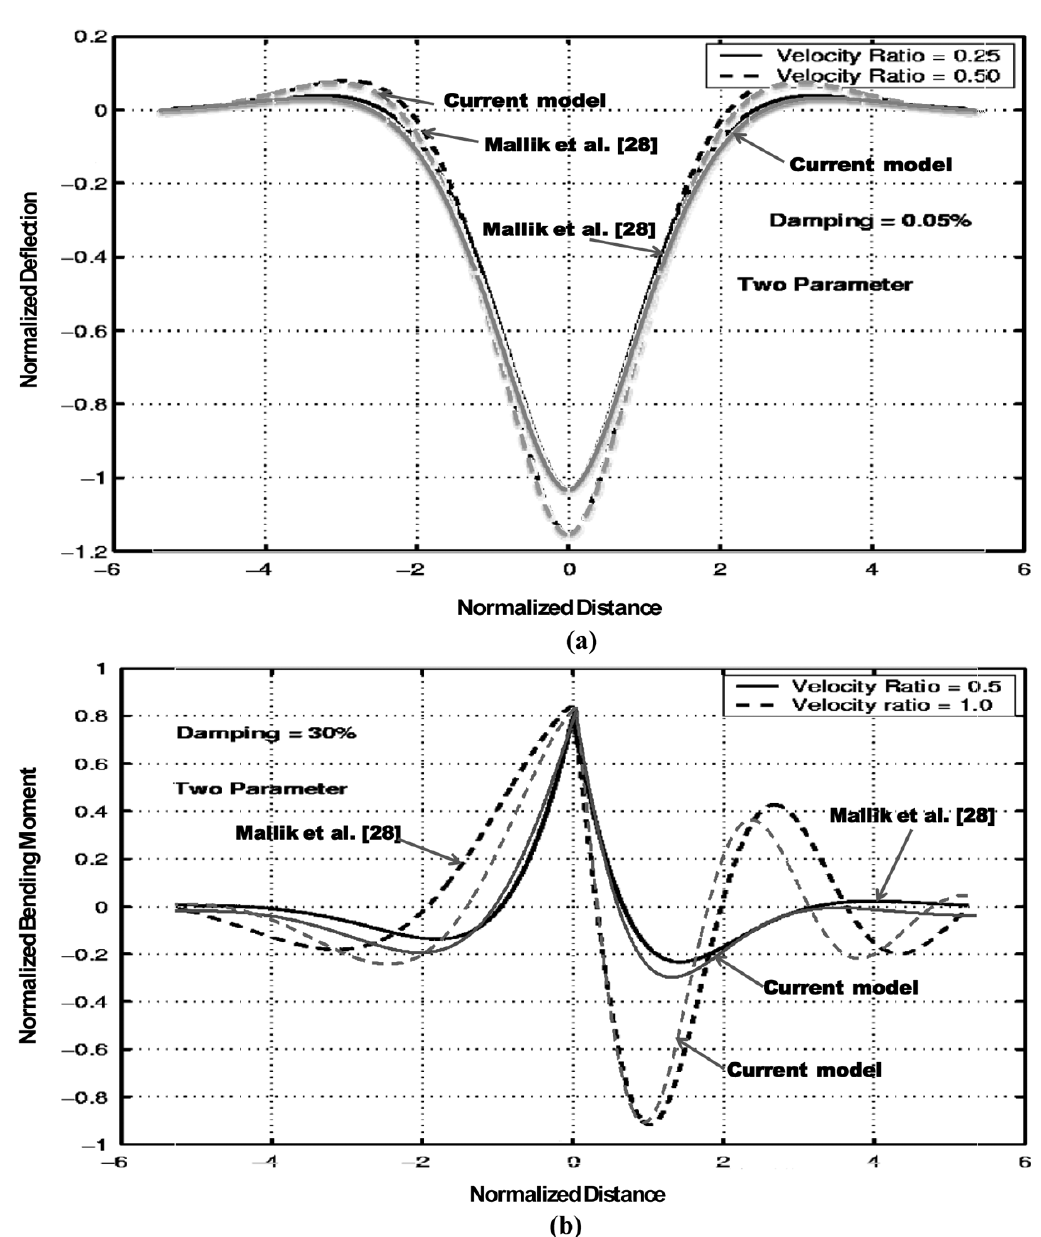
Fig. 3. Comparison of beam (a) de fl ection and (b) bending moment responses of the present model with that reported by Mallik et al. [28]. such as beam de fl ection, bending moment have been obtained for different velocity ratios. All the parameters considered in the validation are taken from Mallik et al. [28] and presented in Table 1. The variations in beam de fl ection and bending moment responses obtained from the present study are evaluated and compared with those reported in [28], as shown in Fig. 3. It can be seen that the de fl ection and bending moment response predicted by the current model agrees reasonably well with the response reported in [28]. The amplitude of de fl ection and bending moment and the period of vibrations predicted by both models are also in very good agreement, although some differences in the bending moment responses become